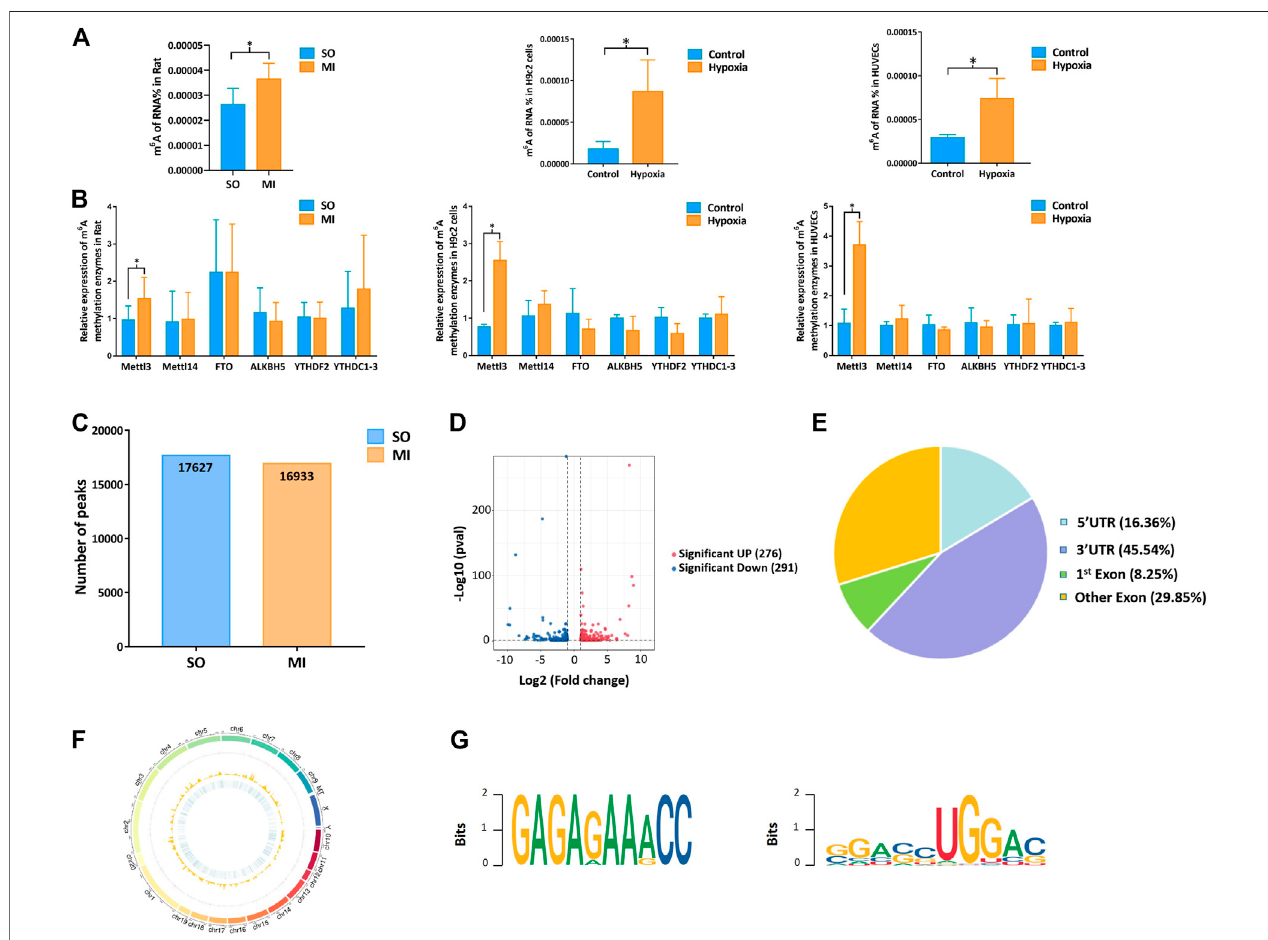
FIGURE 2 | Mettl3 induced upregulation of m 6 A methylation level in myocardial tissue, H9c2 cells, and HUVECs. (A) m 6 A methylation level of MI rat and hypoxic cells; (B) expressionofm 6 AmethylationenzymesinmyocardialtissuesamplesandcellsbyqRT-PCR; (C) numberofpeaksintheSOandMIgroup; (D) volcanoplotsfor differentiallymethylatedm 6 Apeaks; (E) distributionofdifferentiallymethylatedm 6 ApeaksintheSOandMIgroup; (F) distributionpatternsofdifferentiallym 6 Amethylated peaks on chromosomes; (G) sequence motif for the m 6 A peak regions. UTR, untranslated region; Exon, expressed region; SO, sham operated; MI, myocardial infarction. * p <